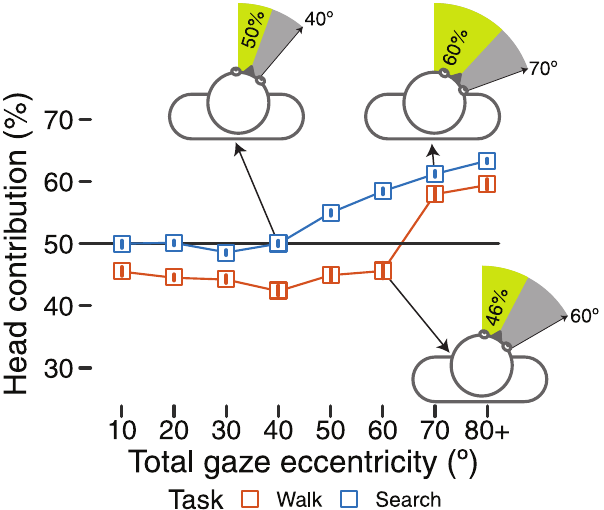
Fig 4. Head contribution to gaze shifts of varying eccentricity (x-axis). Each symbol shows the mean head contribution to a gaze shift—the percentage of the gaze shift accomplished through head rotation as opposed to eye rotation. Symbols above the black horizontal line at 50% indicate that the head contributed more than the eyes; symbols below 50% indicate that the eyes contributed more to the gaze shift compared to the head. Orange symbols represent the walking task and blue symbols represent the search and retrieval task. Error bars (within the symbols) indicate ± 1 standard error. Three top-down drawings of an observer depict the eye contribution (gray shading) versus head contribution (green shading) for gaze shifts at 40 º in the search task, 60 º in the walking task, and 70 º in the search task.